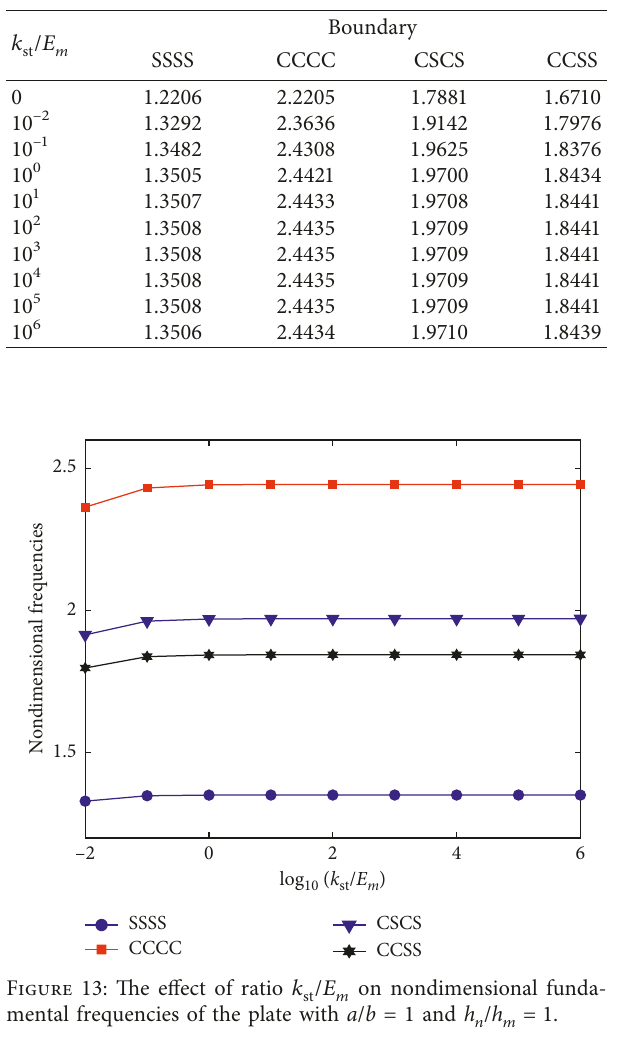
Figure 13: The effect of ratio k mental frequencies of the plate with a / b � 1 and h n / h m � 1.